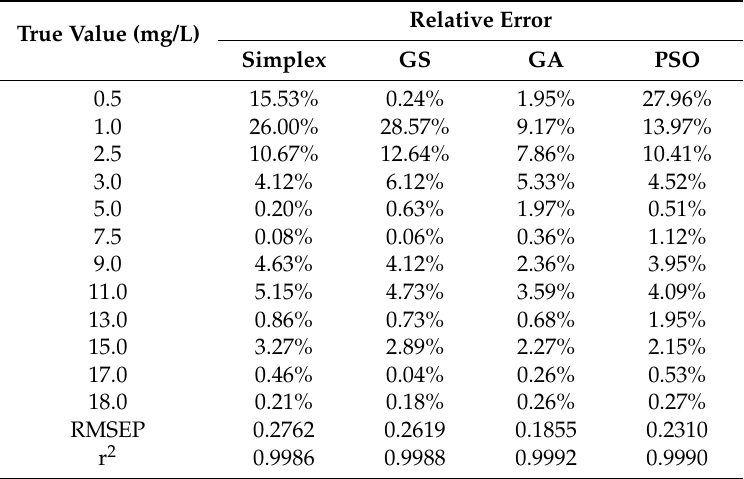
Table 5. Prediction performance on the test dataset in Table